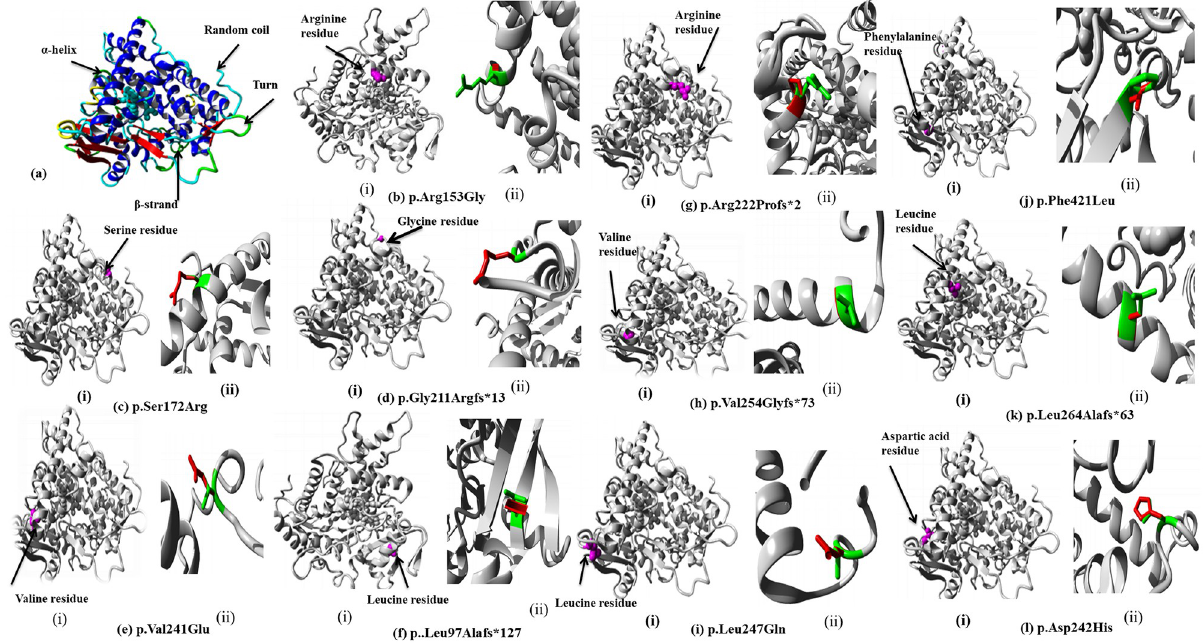
Fig 5. (a) Overview of CYP1B1 wild type protein in ribbon-presentation (b-l) In-silico protein prediction regarding variant protein structures for all detected variants by HOPE software. (b-l) i: for each variant show the position of amino acid in protein structure. (b-l) ii: for each detected variant show the zoomed in change in protein structure due to each respective variant (Wild type amino acid residue is colored as green while mutant is colored as red).